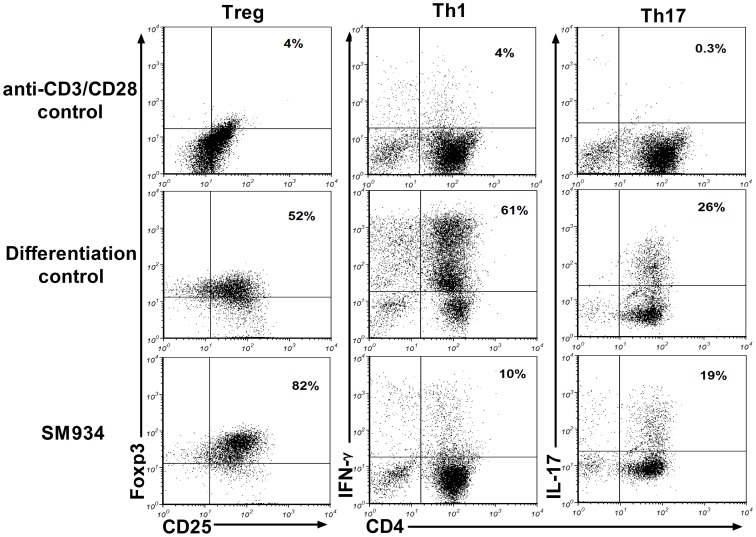
SM934 regulated Th cell differentiation in vitro.Naïve CD4+ T cells in spleens were purified by immunomagnetic positive selection from normal C57BL/6 mice, and cultured in Treg, Th1, Th17 cells differentiation conditions for 96 hours, with or without SM934 (1 µM). Frequencies of Treg, Th1 and Th17 were quantified using flow cytometry. Three independent experiments were performed with similar results.